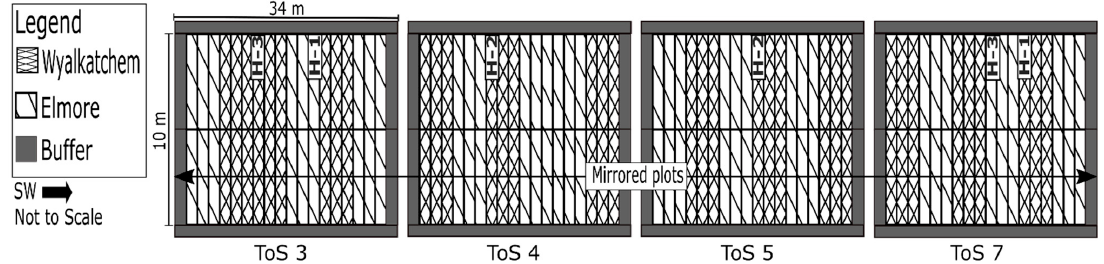
Figure 3. Plot layout at the Dale trial site with the first and second location of heater one (H-1), heater two (H-2) and heater three (H-3) is